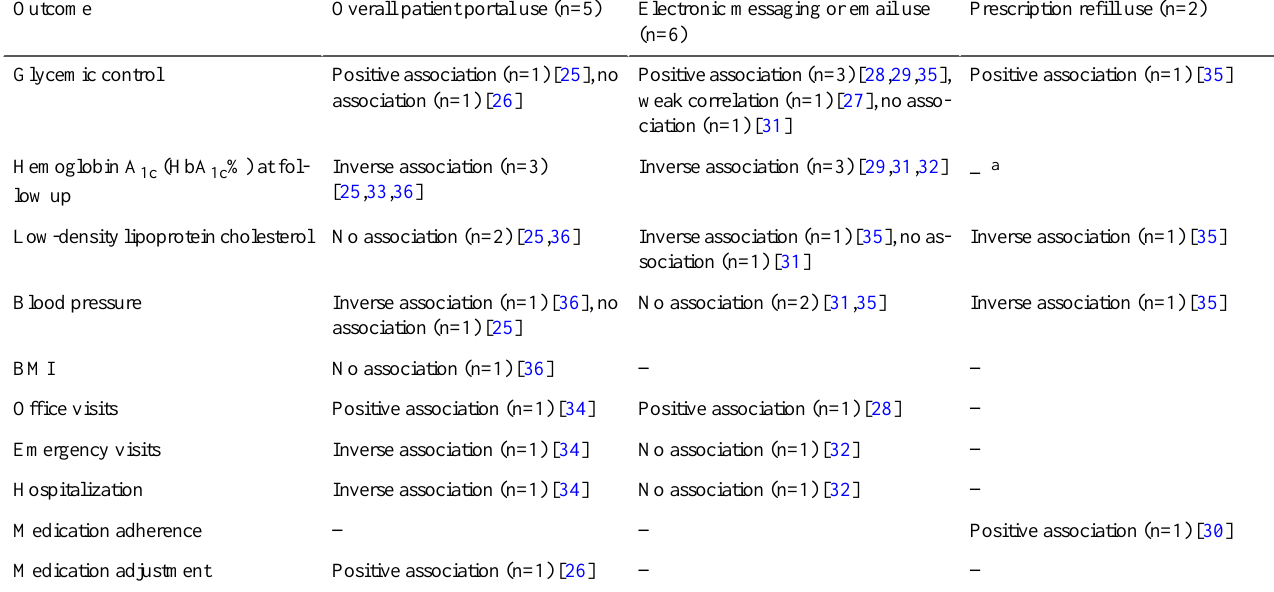
Table 2. Patient portal or patient portal functionality use and the reported associations with diabetes health and health care outcomes in the included